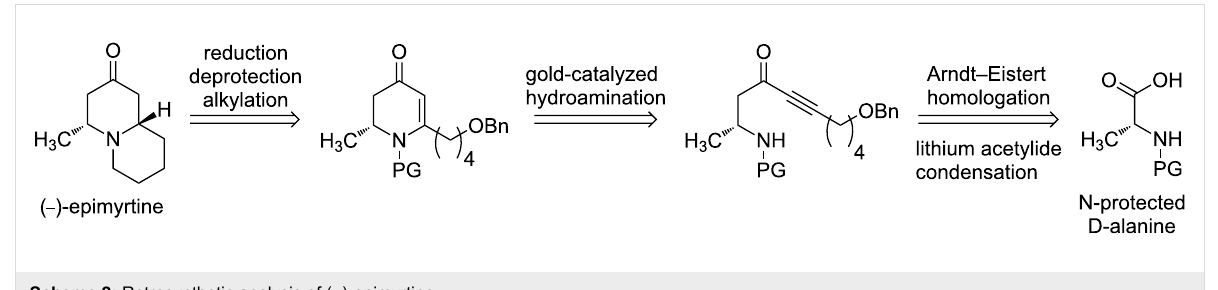
Scheme 2: Retrosynthetic analysis of ( −